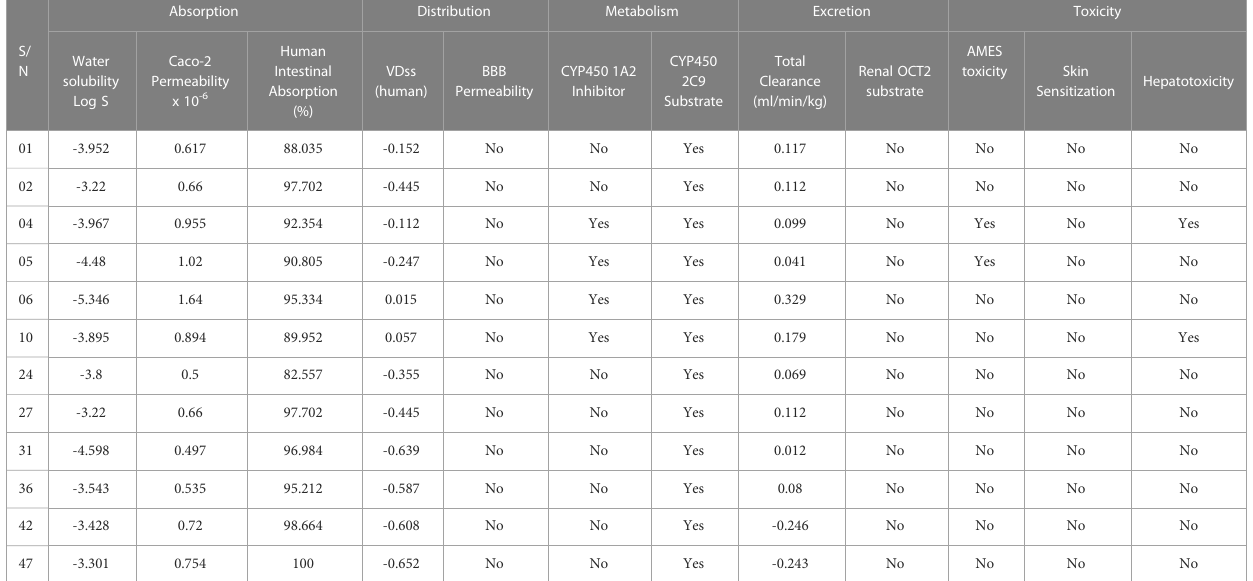
TABLE 5 Summary of in silico ADMET